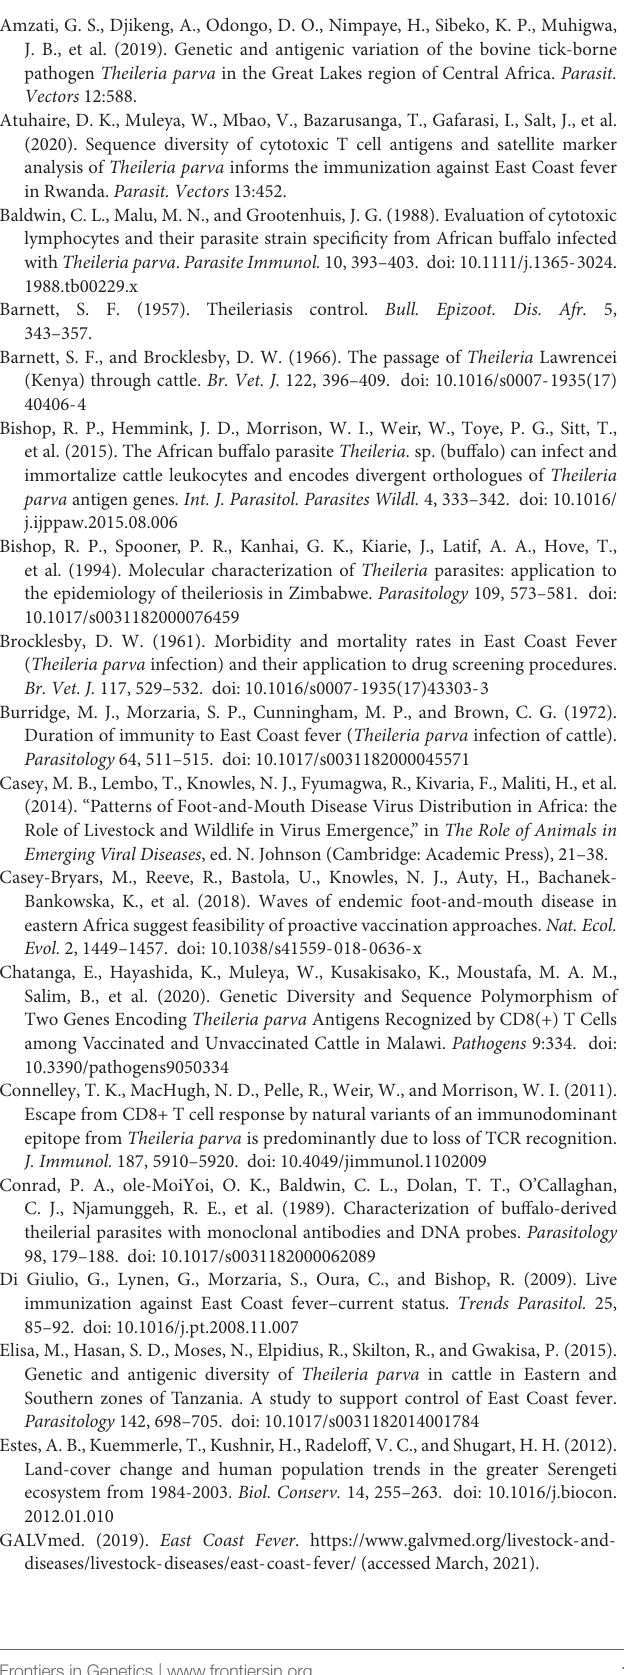
Frontiers in Genetics |